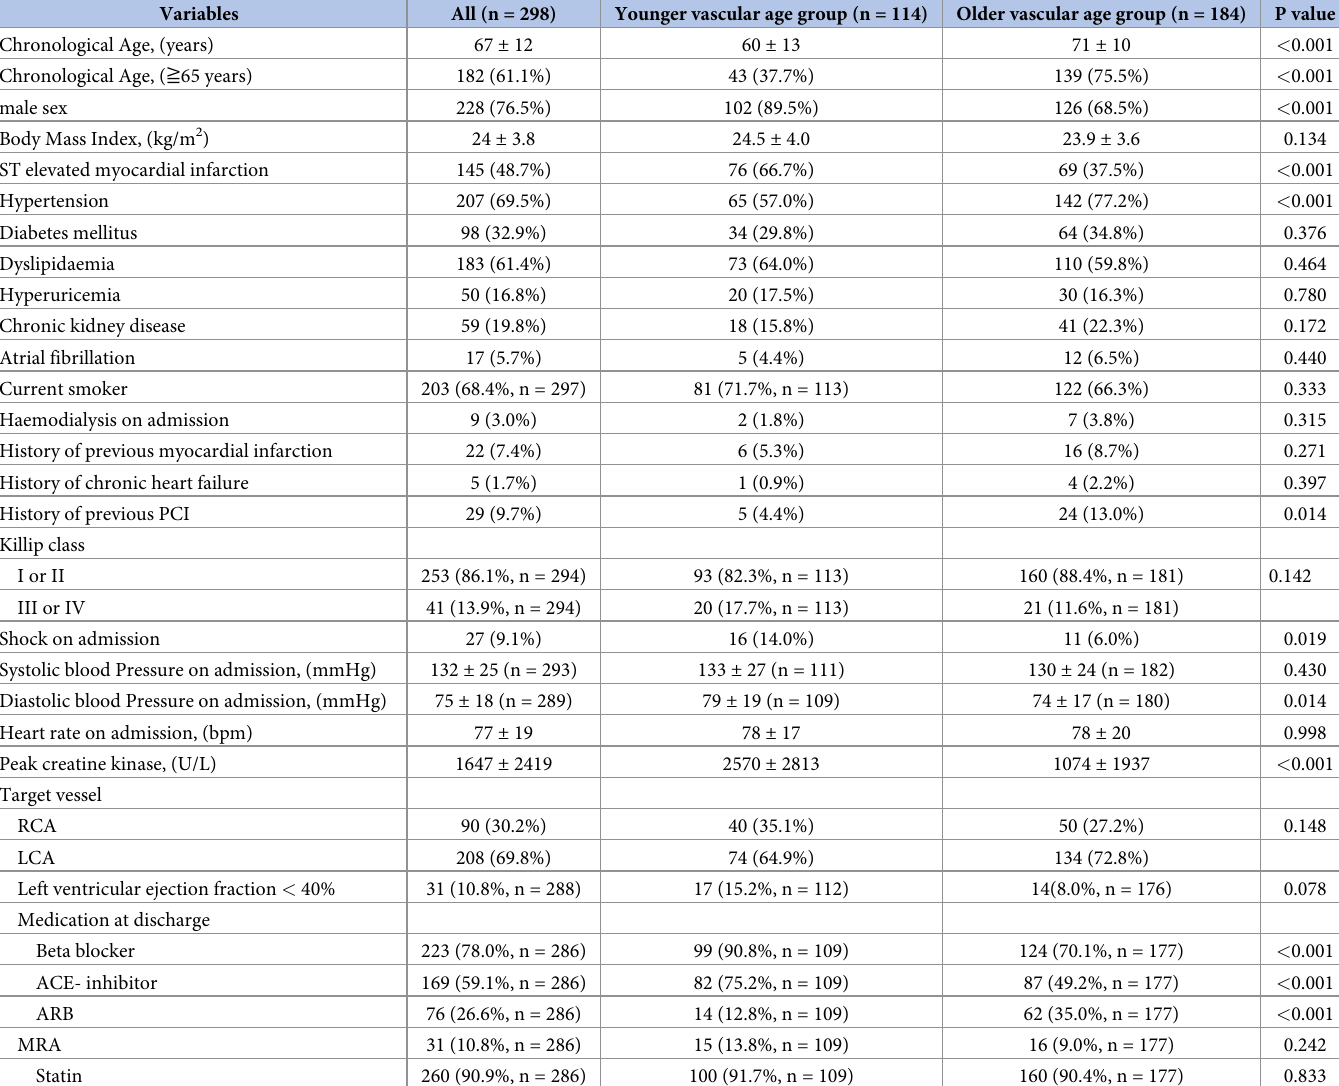
Table 2. Comparison of clinical characteristics between the younger vascular age group and older vascular age